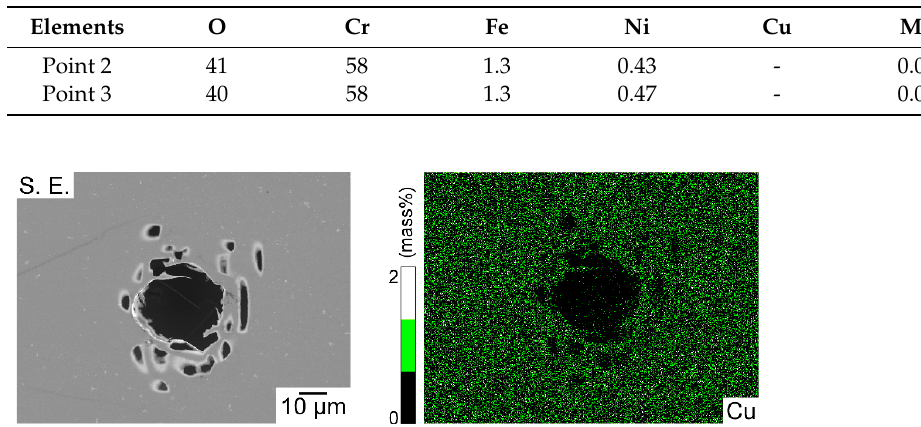
Figure 4. SEM image and corresponding EDS map of Cu around a pit after the polarization shown in Figure 3b.